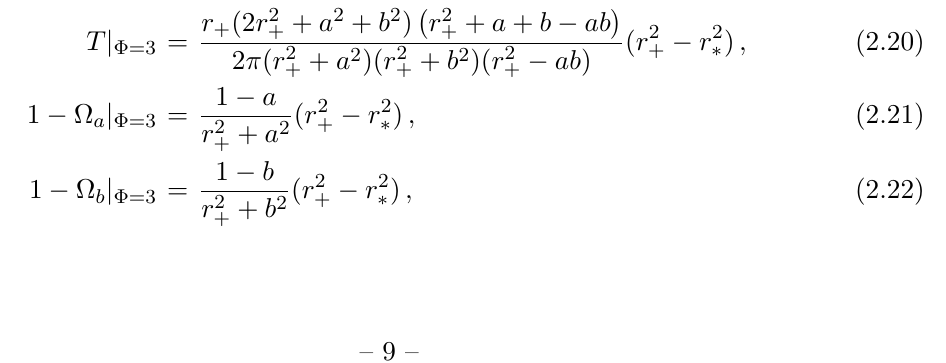
, the free energy and the temperature are both smaller than for a,b